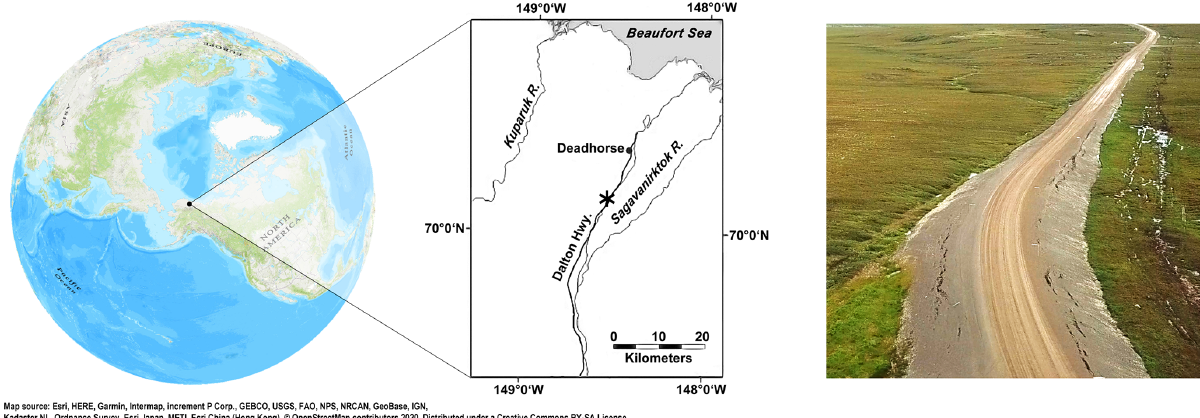
Figure 2. Focus of the model domain in the Prudhoe Bay region, Alaska (Deadhorse; 70.099 ◦ N, 148.511 ◦ W; middle figure). Exemplary drone view of the Dalton highway close to Toolik (right figure). The asterisk in the middle figure illustrates the location of our soil surface temperature monitoring site (see